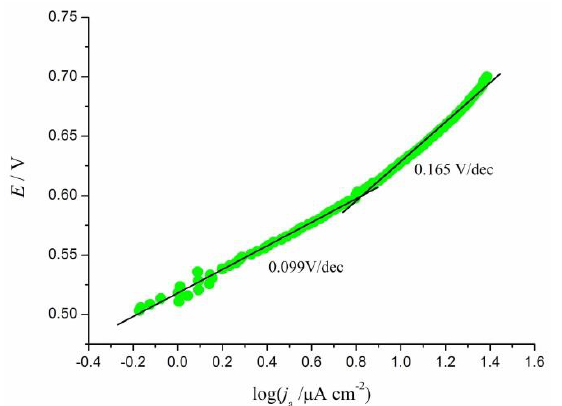
Figure 5. Tafel plots (black line) for the anodic CVA part of rCO 2 oxidation in water saturated with CO 2 after the delay of E = 0.08 V (green